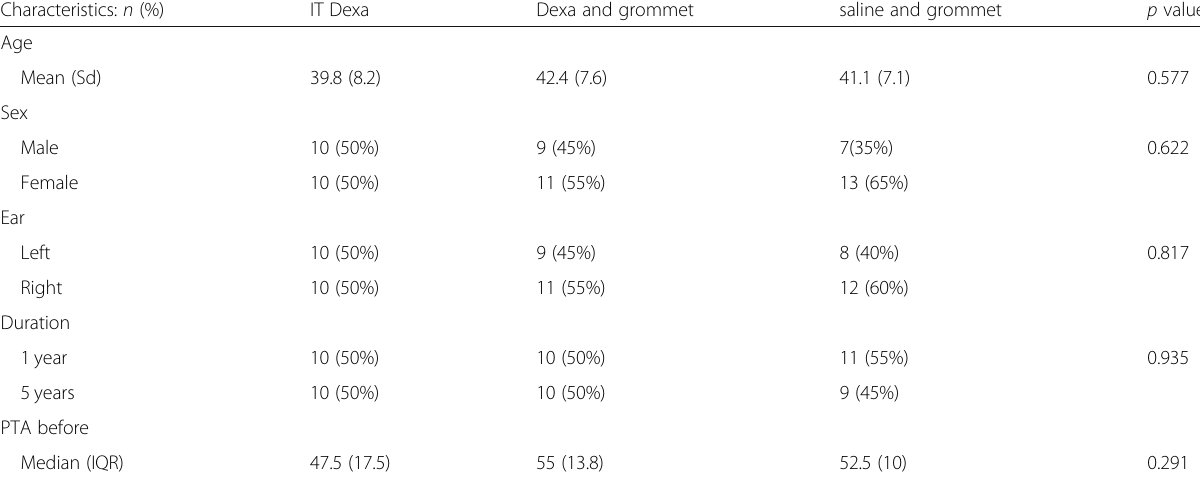
Table 1 Characteristics of the study sample: age by ANOVA test, sex and duration by chi-square test, and PTA by Kruskal-Wallis Test Characteristics: n